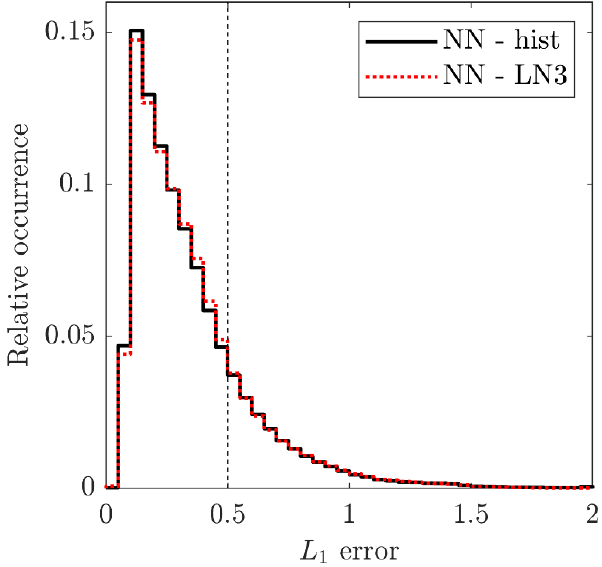
Figure 8. Distributions of testing errors on 1,844,995 examples for the final histogram NN (solid black line) and the LN3 NN (dotted red line) on testing dataset 1. The two distributions are very similar, with most of their differences occurring at 𝐿 (cid:2869) errors less than 0.5 (vertical dashed line).